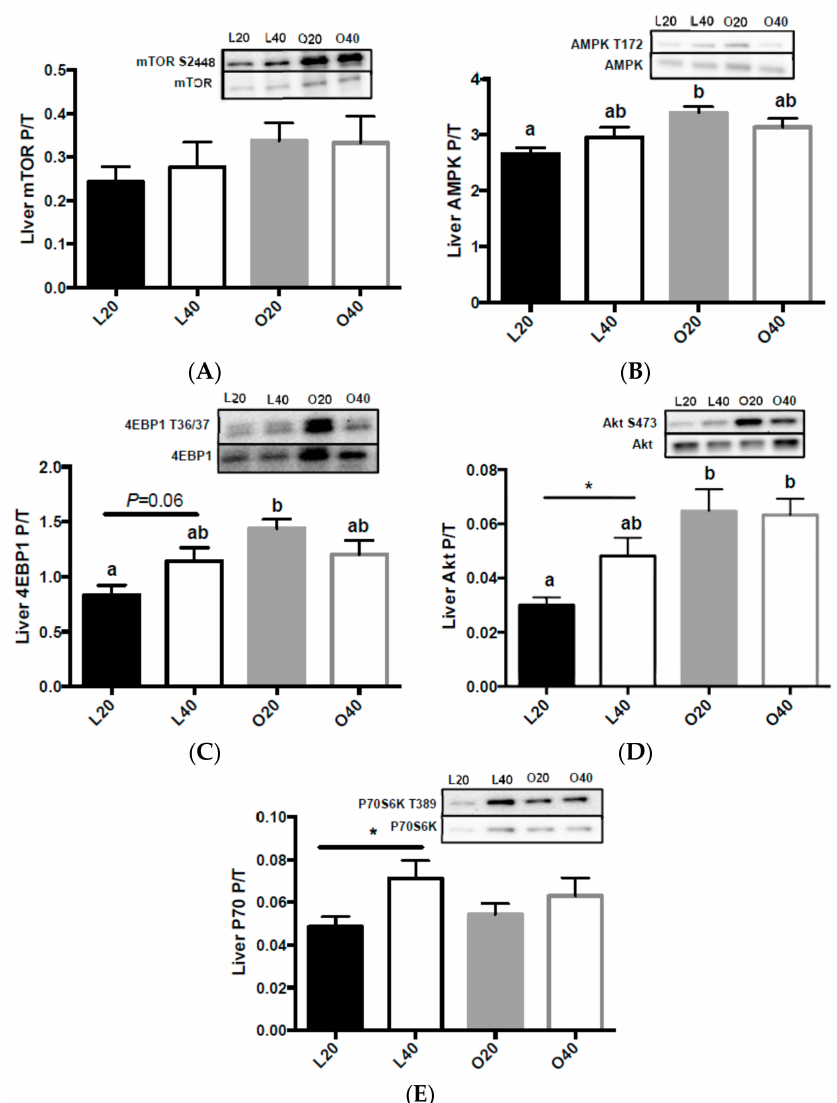
Figure 6. Changes in mammalian target of rapamycin complex 1 (mTORC1) signaling in liver following 12 weeks of consuming either a 20% protein ( n = 8 per group) or 40% protein diet ( n = 10 per group) in lean control (L) or obese Zucker (O) rats. Representative blots are shown, all bands are from the same blot. ( A ) Mammalian target of rapamycin complex 1 (mTORC1) phosphorylation (S2448) over total protein; ( B ) 5 (cid:48) AMP-activated protein kinase (AMPK) phosphorylation (T172) over total protein; ( C ) Eukaryotic translation initiation factor 4E binding protein 1 (4EBP1) phosphorylation (S65) over total protein; ( D ) Protein kinase B (Akt) phosphorylation (S473) over total protein; ( E ) Ribosomal protein S6 kinase 1 (P70) phosphorylation (T389) over total protein. Values are means + SEM. Data was analyzed using one-way ANOVA. Values without a common letter differ, p < 0.05. Values with an * were analyzed via t -test and are significantly different within a group (20% versus 40% protein), p < 0.05. L20, lean 20% protein; L40, lean 40% protein; O20, obese 20% protein; O40, obese 40% protein; P/T, phosphorylated/total